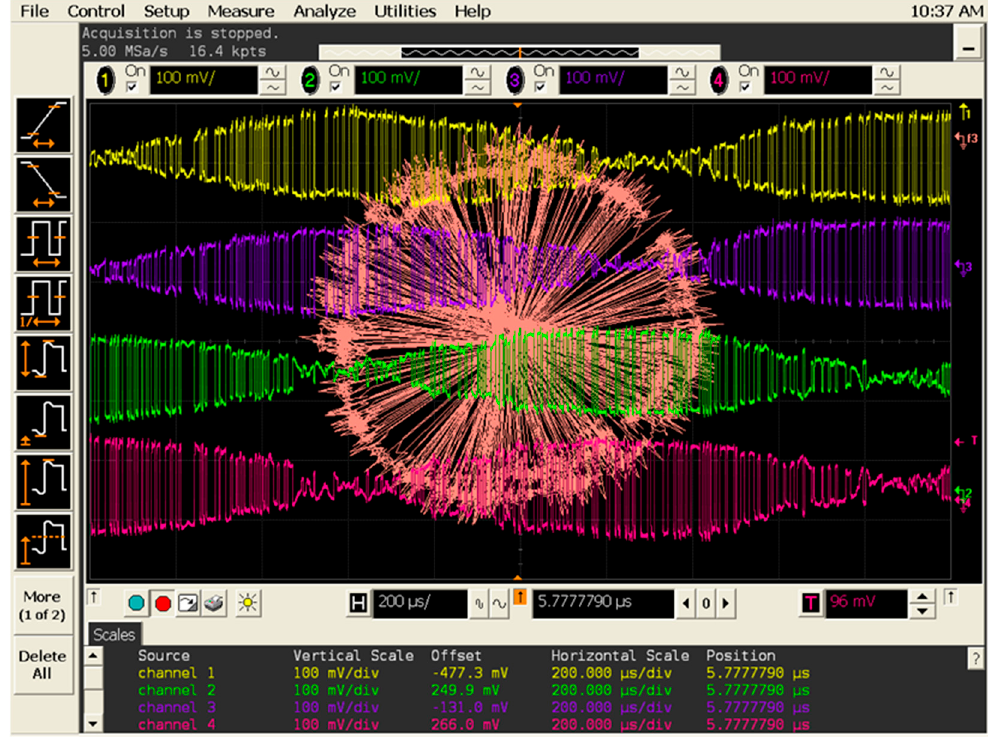
Figure 44. BPSK demodulated signals for a 400 Hz frequency shift between multi-port inputs.